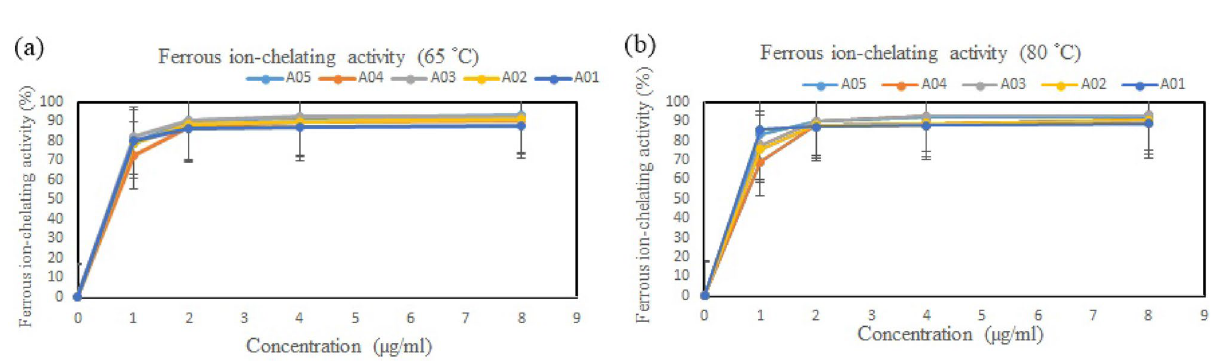
Figure 4. Ferrous ion-chelating activity of fucoidan obtained from S. ilicifolium at different locations that was extracted at ( a ) 65 °C and ( b ) 80 °C. Bars indicate SD, n =